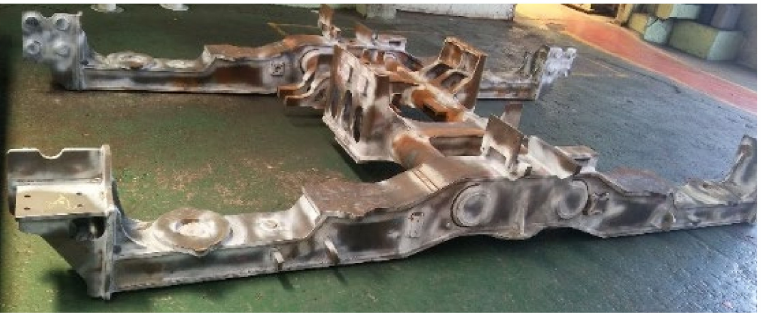
Figure 1. A bogie frame made by welding for a rail